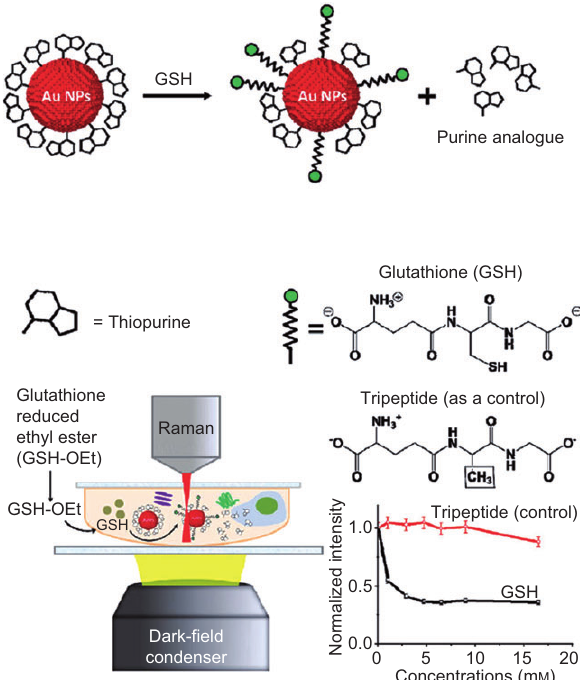
Figure 15 Illustration of the experimental procedure adopted for the in vitro release of 6MP or 6TG drug molecules previously adsorbed on AuNPs, using GSH-OEt as an external activator. Reproduced with permission from: Ock et al. (2012) . Copyright 2012, American Chemical